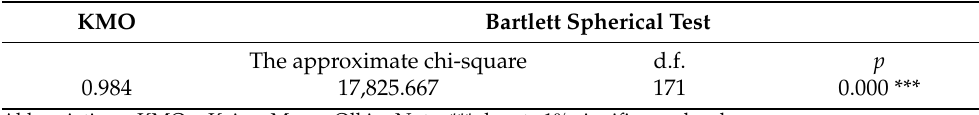
Table 5. KMO value and Bartlett’s sphericity test.